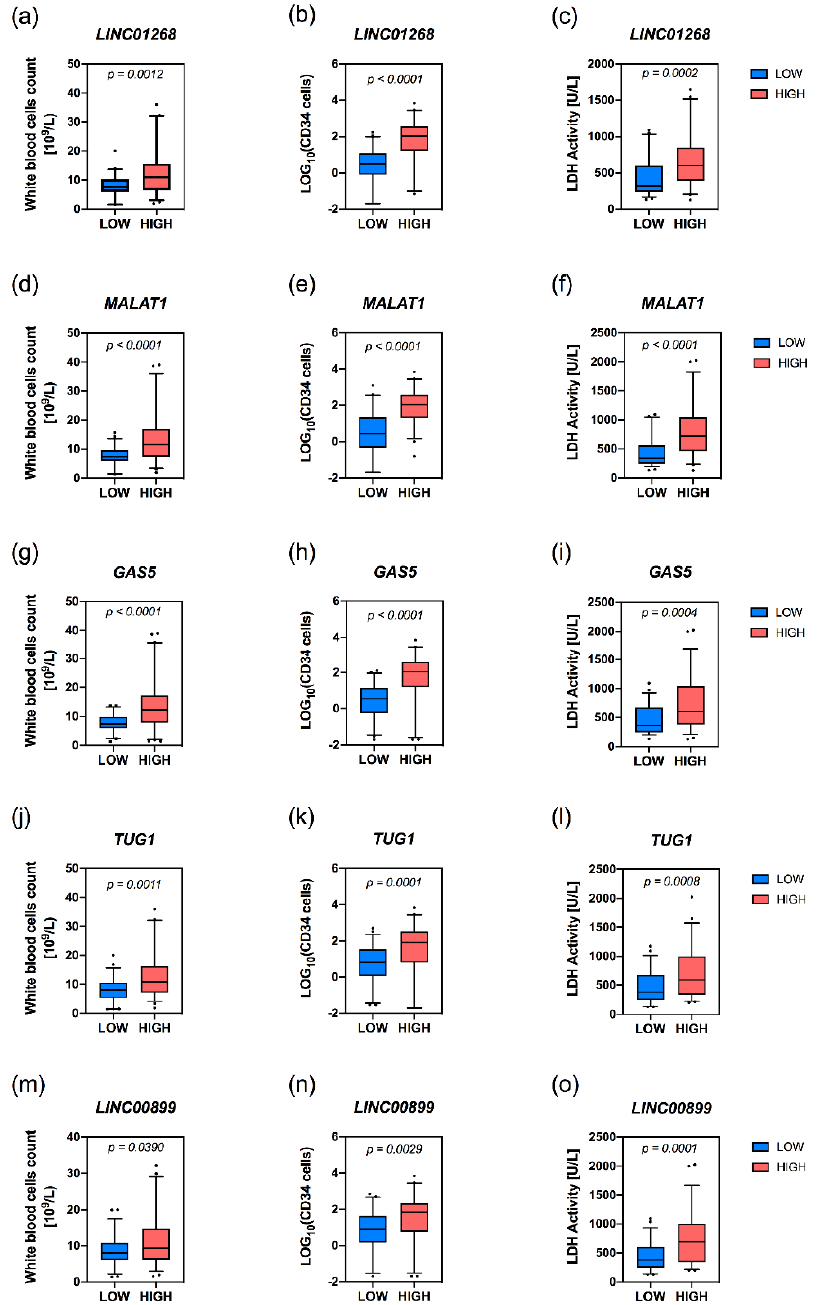
Figure 3. Correlation analysis of level of circulating lncRNAs with WBC count, circulating CD34+ count and LDH activity in MF patients. Box plots represent values from white blood cell count (WBC) ( a , d , g , j , m ), CD34+ cells count ( b , e , h , k , n ) and LDH activity ( c , f , i , l , o ) in MF samples presenting low or high levels of target RNA. The box extends from the 25th to the 75th percentiles. The line in middle of the box is plotted as the median. The whiskers are drawn as 5th and 95th percentiles. Values above or below the whiskers are plotted as individual points. Samples with low or high levels of target lncRNA are represented by blue and red boxes, respectively. p = p -value was computed by non-parametric Mann–Whitney U test.